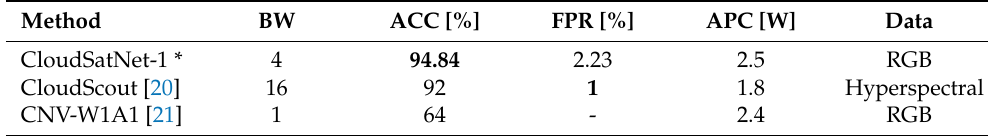
Table 10. Comparison of the best-performed models with different